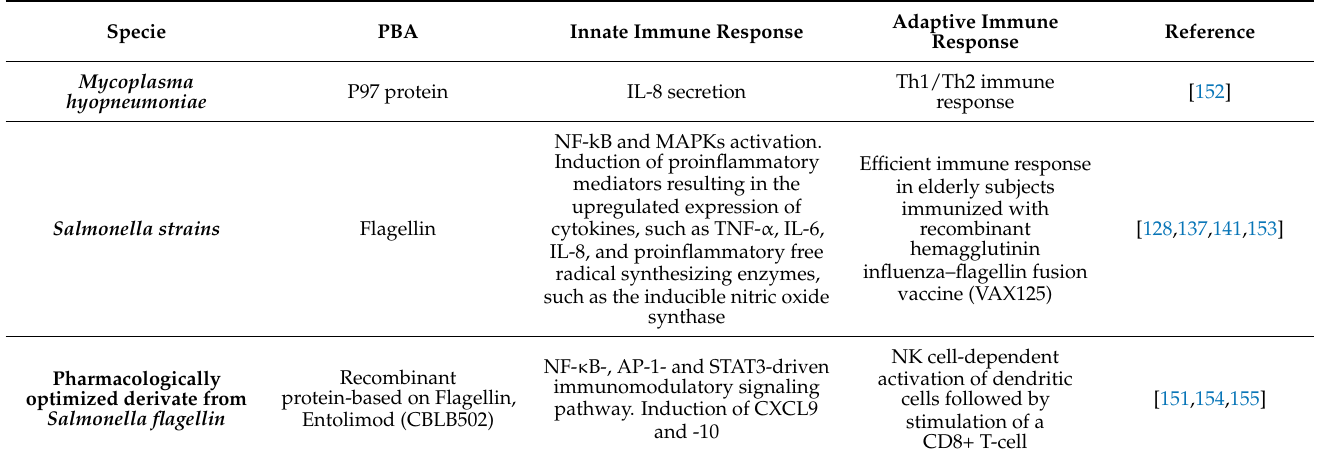
Table 4. PBAs with TLR5 adjuvant